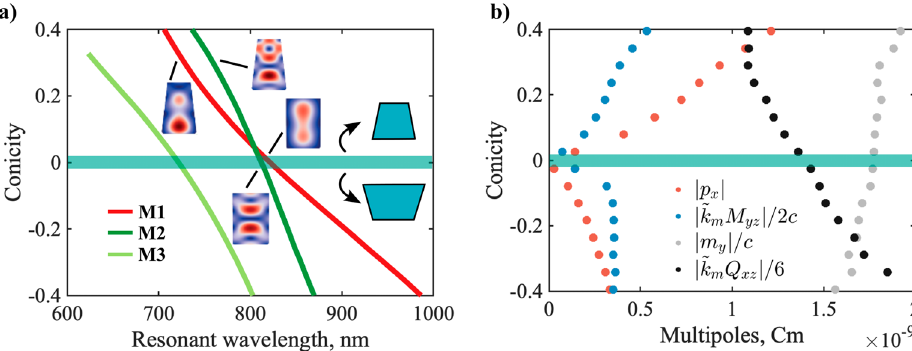
Figure 7. ( a ) Resonant wavelength shifts of the QNMs in the vicinity of the HA, as a function of conicity. In an unperturbed cylinder, QNMs M1 and M2 correspond to TE 120 and TM 113 discussed in Ref. 33 . M3 is associated with TM 111 . Insets depict the internal fields of the QNMs for selected values of conicity (red–more intense field, blue–less intense field). In all the calculations we neglected the dispersion of Si, and fixed its value to an average in the spectral range under consideration, n ≈ 3.45 . ( b ) Intrinsic multipole moments of M2 as a function of conicity. To allow a proper visualization, all moments are normalized in ED units, i.e. C.m. ˜ k m = ˜ ω m / c is the (complex) wavevector associated with the m-th